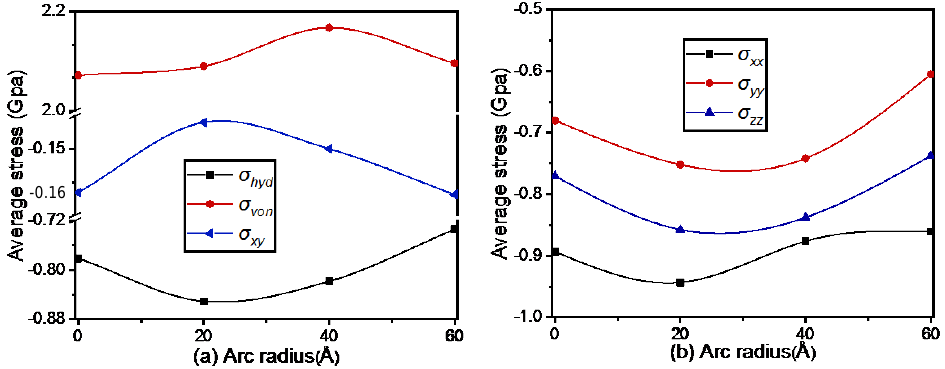
Figure 4. Variation of stresses with arc radius of the tool trajectory: ( a ) hydrostatic stress, von Mises stress, shear stress; ( b ) normal